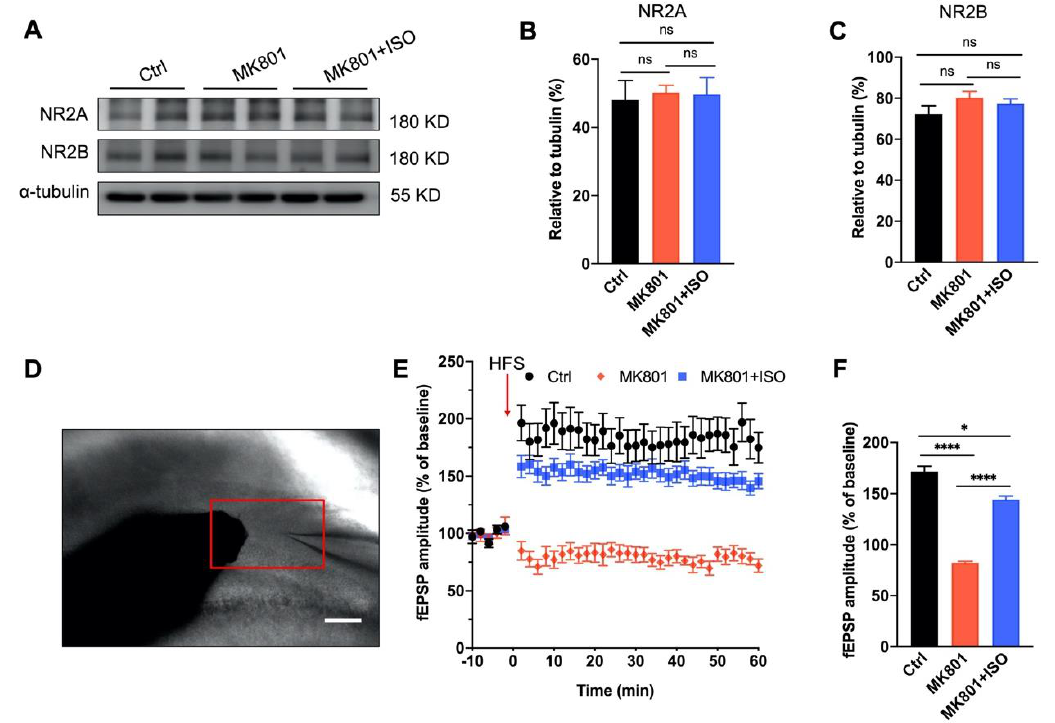
dentate granular cells. Scale bar, 10 µ m. ( H ) The reduction of dendritic branches of newborn dentate granular cells reversed by isoflurane treatment (five mice in each group and five sections in animal were picked, and three cells of each section were analyzed and counted. One-way ANOVA, F (2, 39) = 62.68, p < 0.0001; post hoc test: Ctrl vs. MK801, p < 0.0001; MK801 vs. MK801+ISO, p < 0.0001; Ctrl vs. MK801+ISO, p = 0.62). Data are represented as mean ± SEM, ** p < 0.01, *** p < 0.001, **** p < 0.0001, ns, not significant.